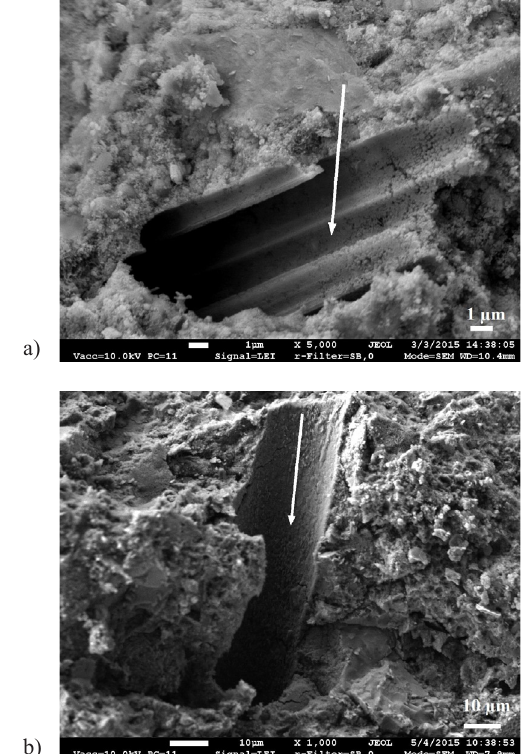
Table 4. Work of fracture and TSR of castable samples after